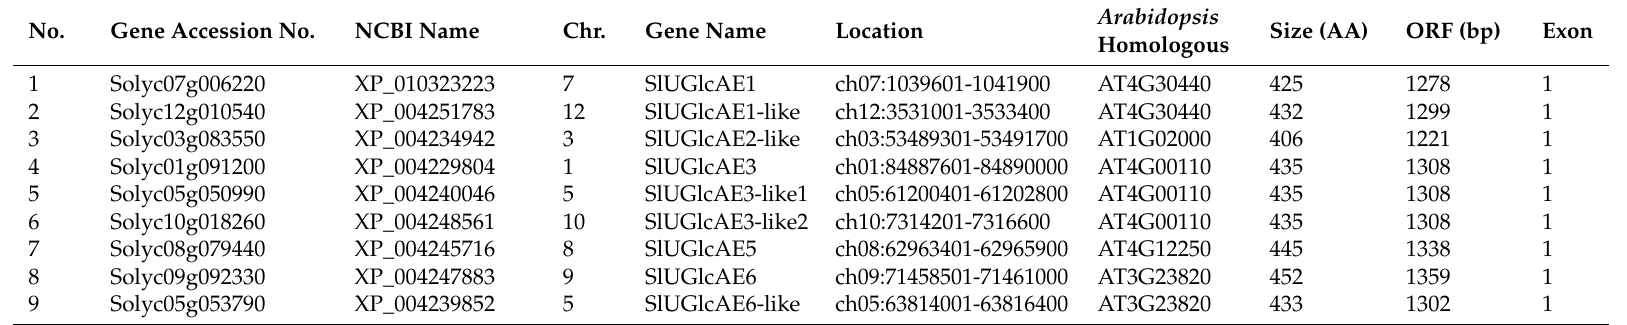
Table 1. Information about the nine isoforms of the tomato SlUGlcAE gene